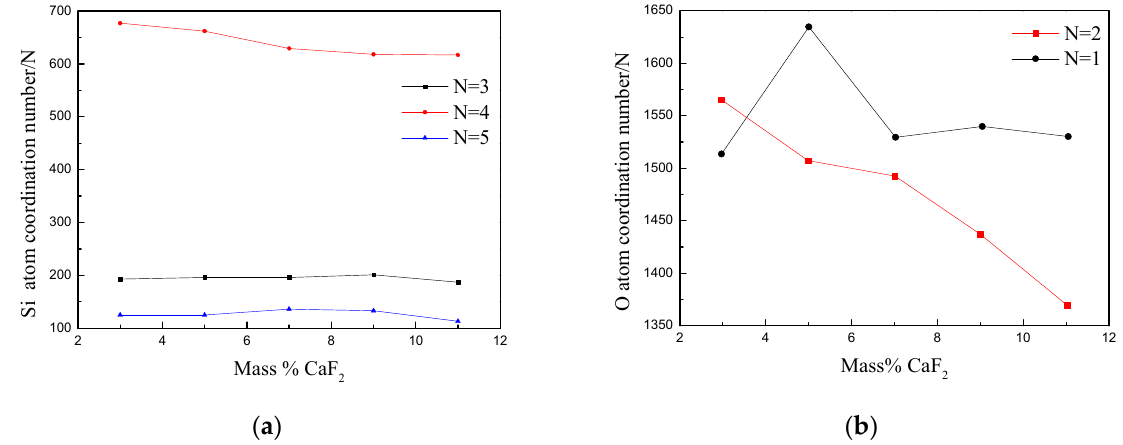
Figure 10. Number of atoms coordinated to ( a ) Si and ( b ) O at different CaF 2 contents.